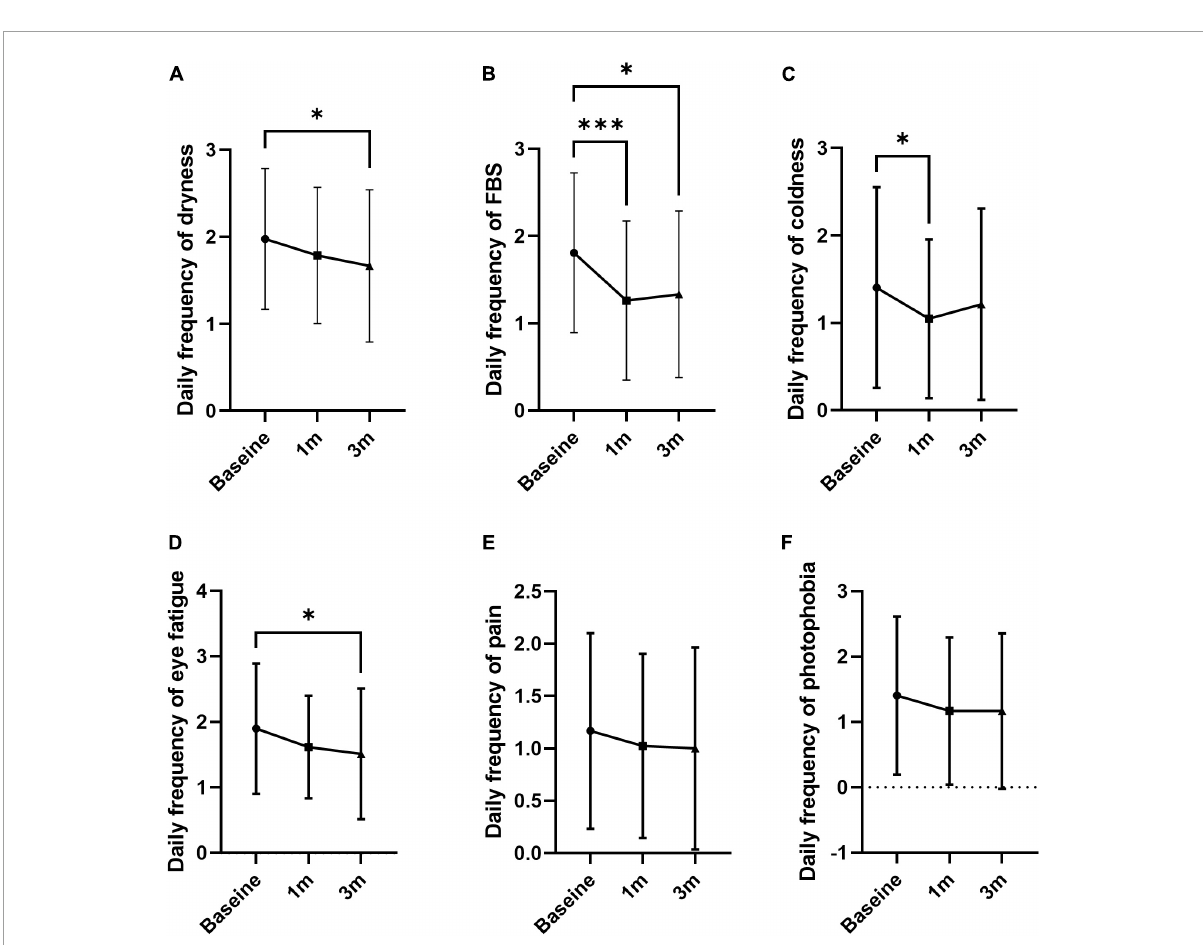
FIGURE3 The effect of MVG on the frequency of each dry eye symptom. (A) Dryness. (B) Foreign body sensation. (C) Coldness. (D) Eye fatigue. (E) Pain. (F) Photophobia. ∗ < 0.05, ∗∗ < 0.01, and ∗∗∗ p <